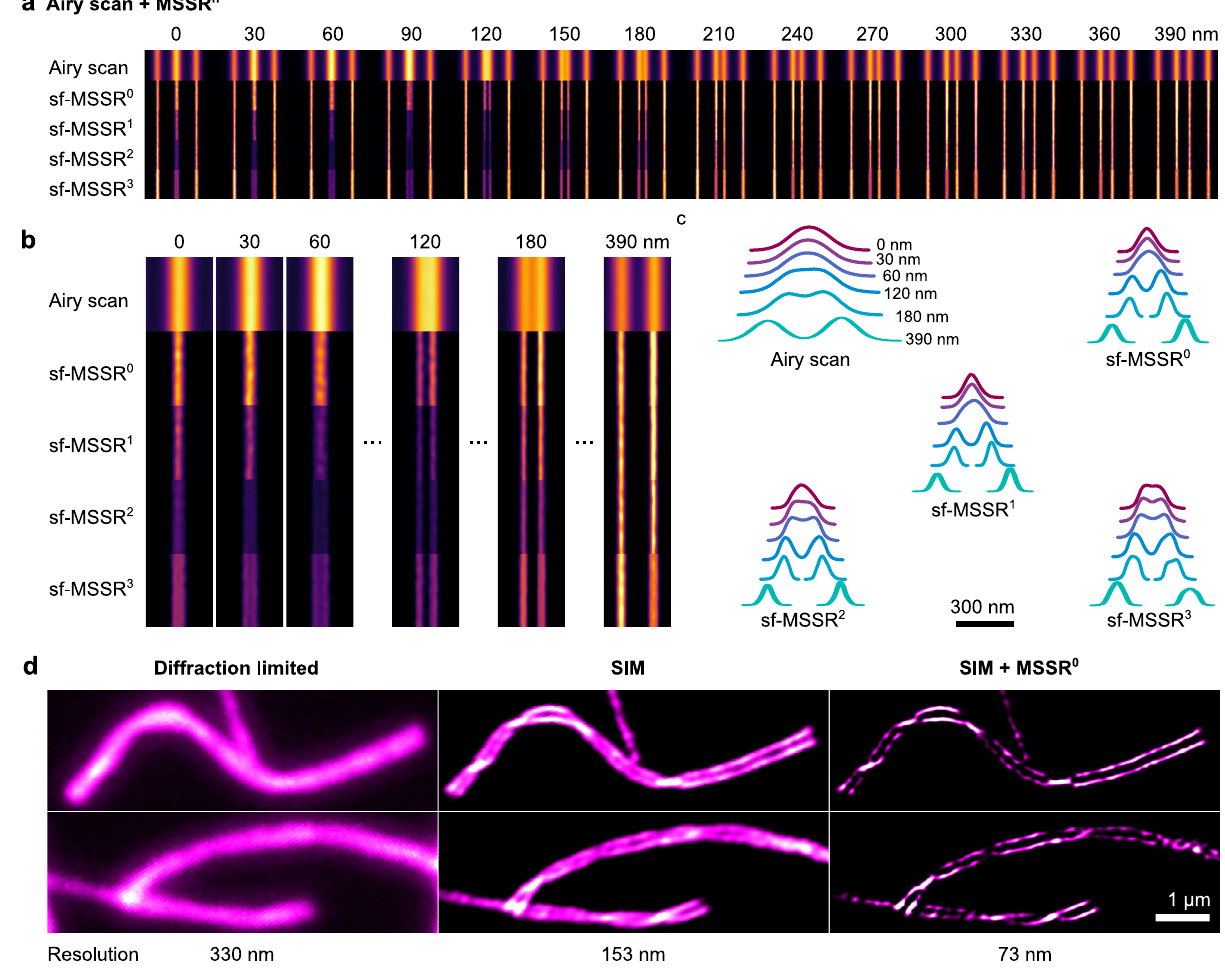
d sf-MSSR 0 applied to SIM reconstruction of chromosome axis. d Synapsed homologsmeioticchromosomesofmouse,visualizedbyTIRFM(left),SIM(middle) andSIM+MSSR 0 (right).Imagesin( a )a( b )correspondtotheensembleaverageof 31 consecutive sections (width=1 µ m) along the Argo-SIM micropattern E. Reso- lution in d was measured with the image decorrelation plugin of FIJI/image 34